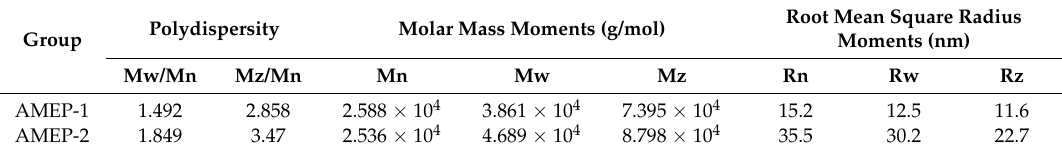
Figure 2. HPSEC-MALLS chromatographic profiles and IR spectra ofAMEP-1 and AMEP-2: ( A ) HPSEC-MALLS chromatographic profile of AMEP-1; ( B ) HPSEC-MALLS chromatographic profile of AMEP-2; ( C ) IR spectrum of AMEP-1; and ( D ) IR spectrum of AMEP-2. Table 1. Experimental Results of MALLS for AMEP-1 and AMEP-2.